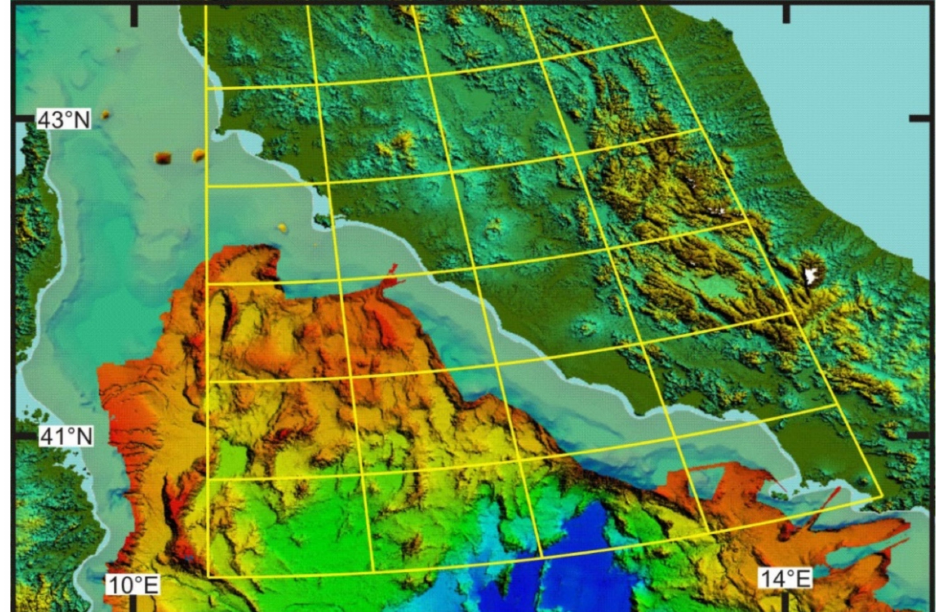
Figure 13. Morpho-structural lineaments of the central Apennine and Euler pole grid of relative motion with respect to Sardinia-Corsica. The Euler pole grid shows the goodness of fit between kinematic model and geological structures. The Euler pole has coordinates: 48.9 ◦ − 10.4 ◦